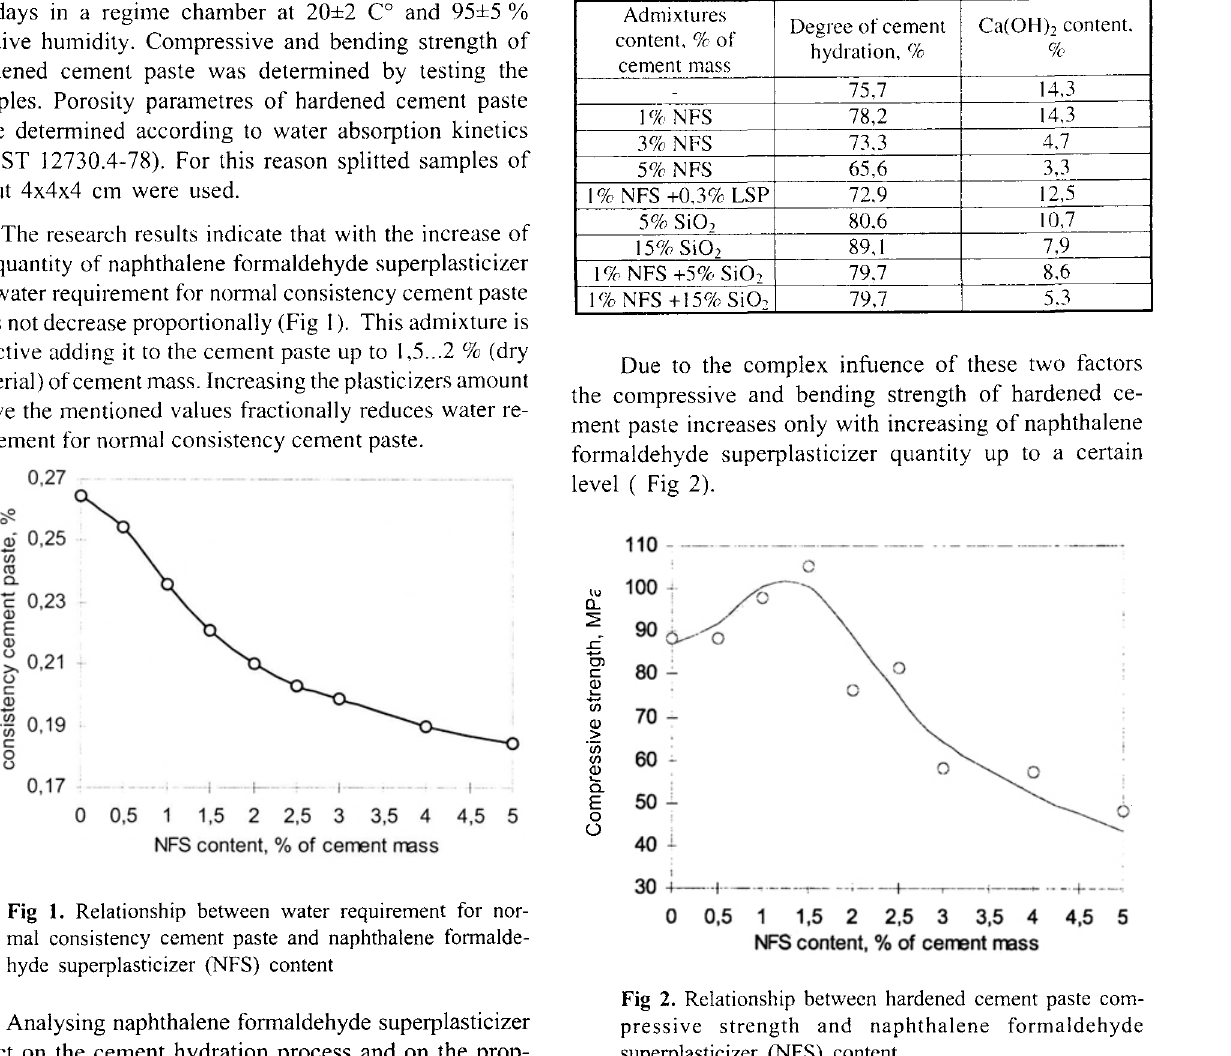
Fig 2. Relationship between hardened cement paste com pressive strength and naphthalene formaldehyde superplasticizer (NFS) content The optimum quantity of naphthalene formaldehyde superplasticizer with respect to hardened cement paste strength is 1,0 .. . 1 ,5% of the cement mass. The capillary porosity of cement paste distinctly decreases, but the size of capillary pores increases with adding naphthalene formaldehyde superplasticizer. Bigger than 1,0 ... 1,5 % quantities of formaldehyde superplasticizer decrease water requirement for cement paste ineffectively and even decrease the strength of hardened paste. duction and to increase the strength of hardened cement paste it is possible to use admixture of lignosulfonate. cement mass water requirement for a normal consistency of cement paste increases proportionally with admixture quantity (Fig 3) and compressive strength of hardened cement paste increases proportionally and reaches con siderably high values (Fig